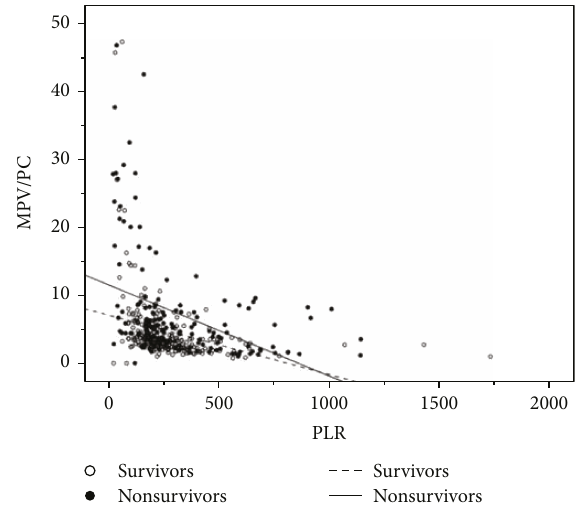
Figure 2: Scattergram of MPV/PC versus PLR for all patients (survivors and